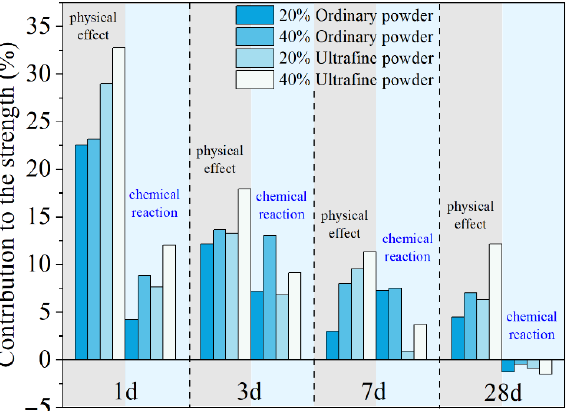
Figure 4. Quantitative contributions of the physical and chemical effects on the mechanical properties of MKPC mortar.